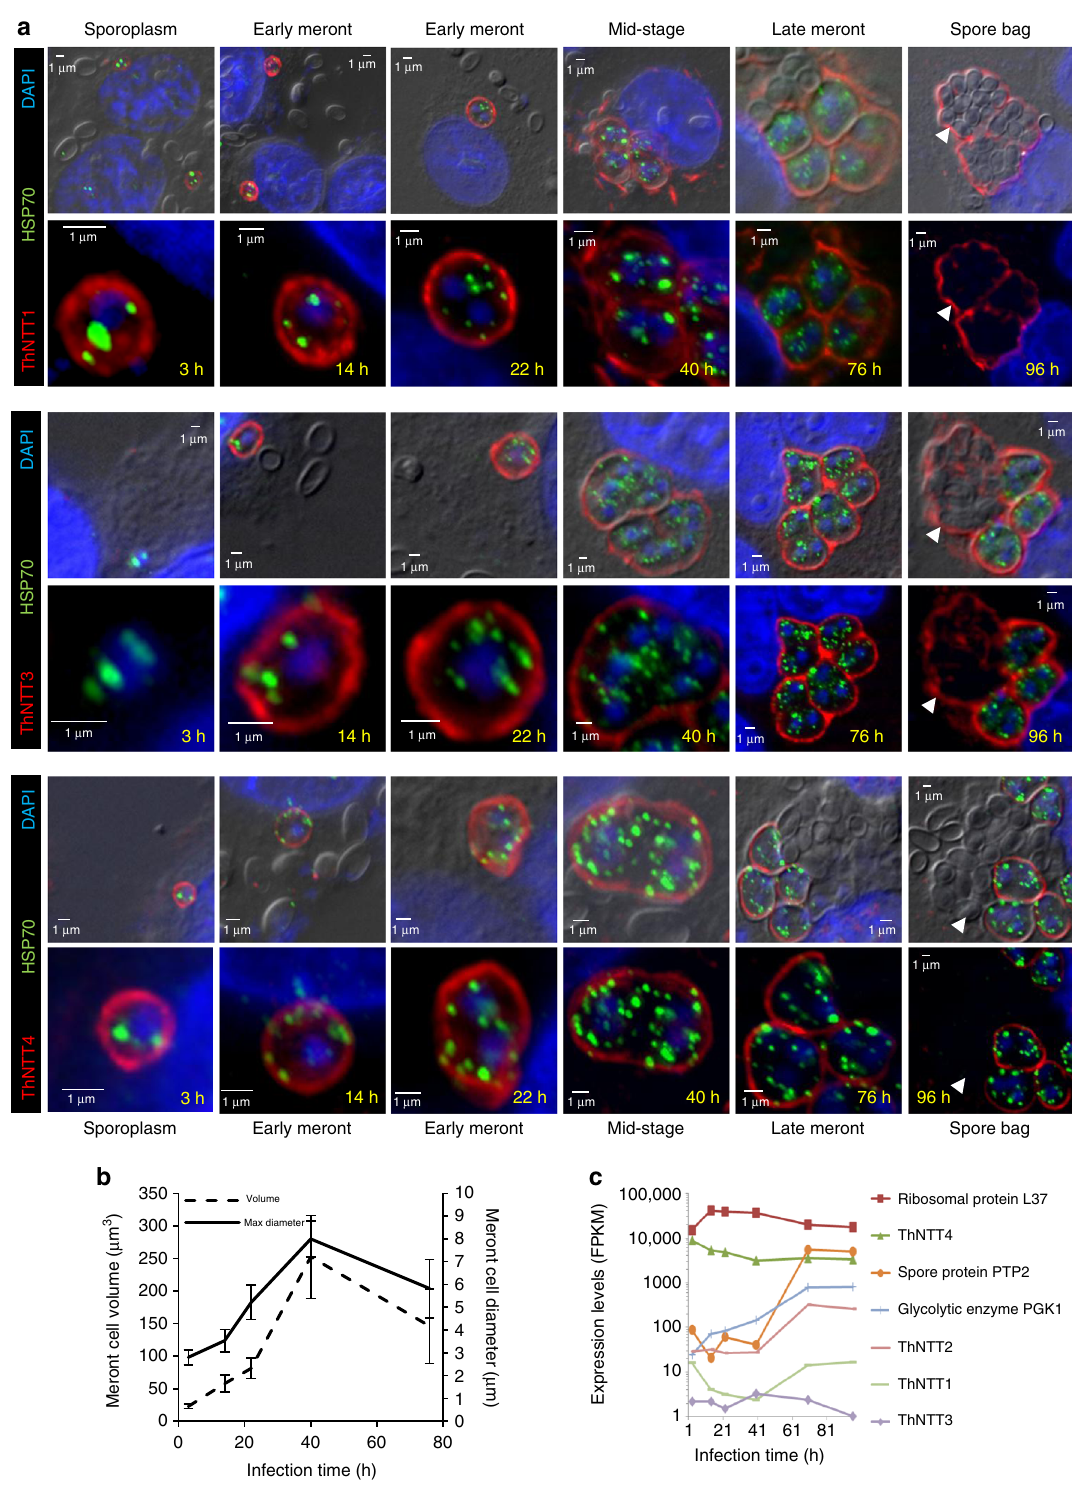
Fig. 4 Protein localisation and transcript abundance for T. hominis NTT transporters over a time course of T. hominis infection. a Immuno fl uorescence time course (3 – 96 h) of rabbit kidney (RK-13) cells infected with T. hominis spores using published 15 individual rabbit anti-ThNTT antibodies (red). Rat anti- HSP70 15 (green) was used to label the mitosomes of intracellular parasites (meronts). The fi rst time point at 3 h is shortly after injection of the T. hominis sporoplasm into the host cell when labelling by antisera to ThNTT1 and ThNTT4 is already apparent. The top DIC image shows the spore bags (arrows) at 96 h with superimposed labelling (red) by antisera to ThNTT1 and ThNTT3 but not by antisera to ThNTT4. Scale bar is 1 µ m. b Increase in parasite biomass during T. hominis infection time course measured using cell diameter and cell volume. Diameter of parasite cells (minimum 100 counted) was taken at their widest point, and cell volumes were calculated using Axiovision software. Error bars are standard deviation. N = 3. c RNAseq analysis showing transcript abundance (log 10 FPKM (Fragments per kilobase per million mapped reads)) for the four ThNTTs, spore protein (PTP2), a glycolytic enzyme (PGK1) and ribosomal protein L37 throughout the infection time